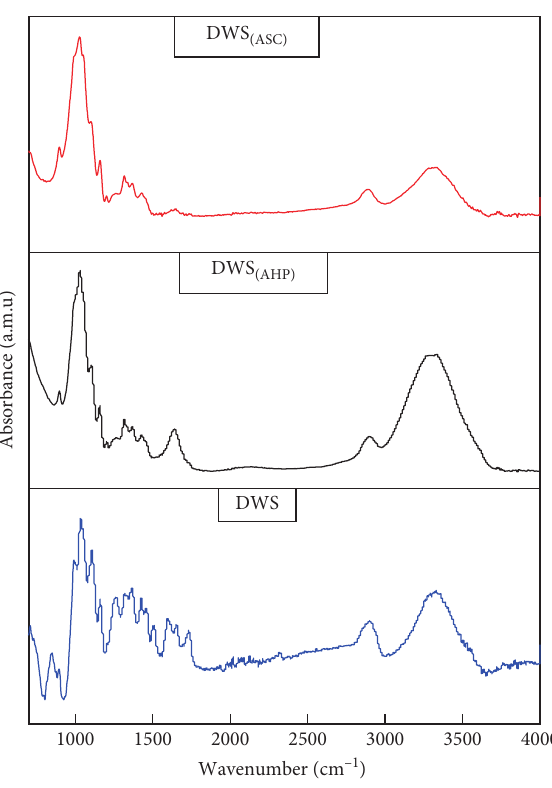
Figure 1: FT-IR analysis of DWS, DWS